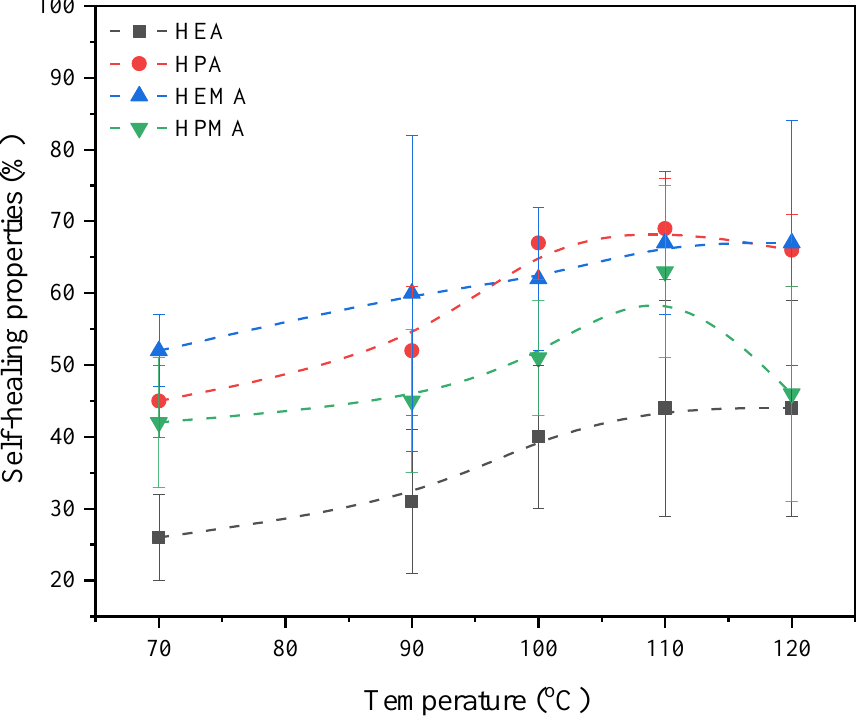
Figure 14. Self-healing properties based on microscopic images of UA-DA films heated to different temperatures. Table 5. Optical microscopy images of self-healing properties of coatings with scratches on the UA- DA films heated to different temperatures.